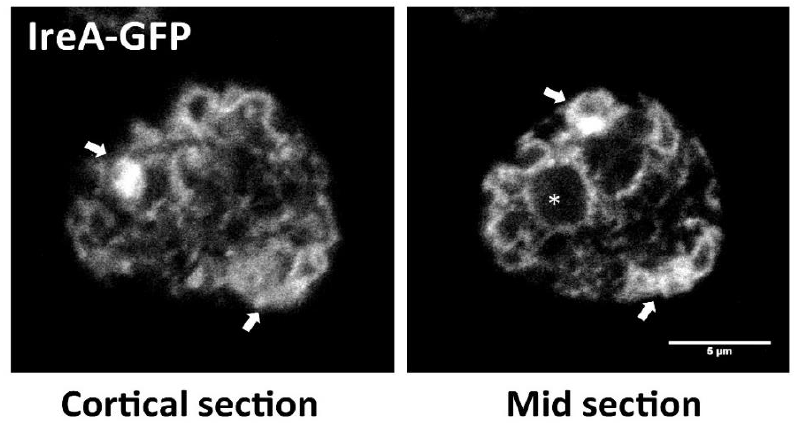
Figure 2. The Dictyostelium endoplasmic reticulum (ER). In vivo confocal microscopy pictures showing a cortical section and a mid-section of a wild-type (WT) cell expressing the ER marker, Inositol requiring enzyme A (IreA) fused to the GFP. The asterisk pinpoints the nucleus, surrounded by the perinuclear ER. Arrows highlight zones where sheet-like regions are evident. Tubules can be distinguished across the entire cell area. (Scale bar represents 5 μm).